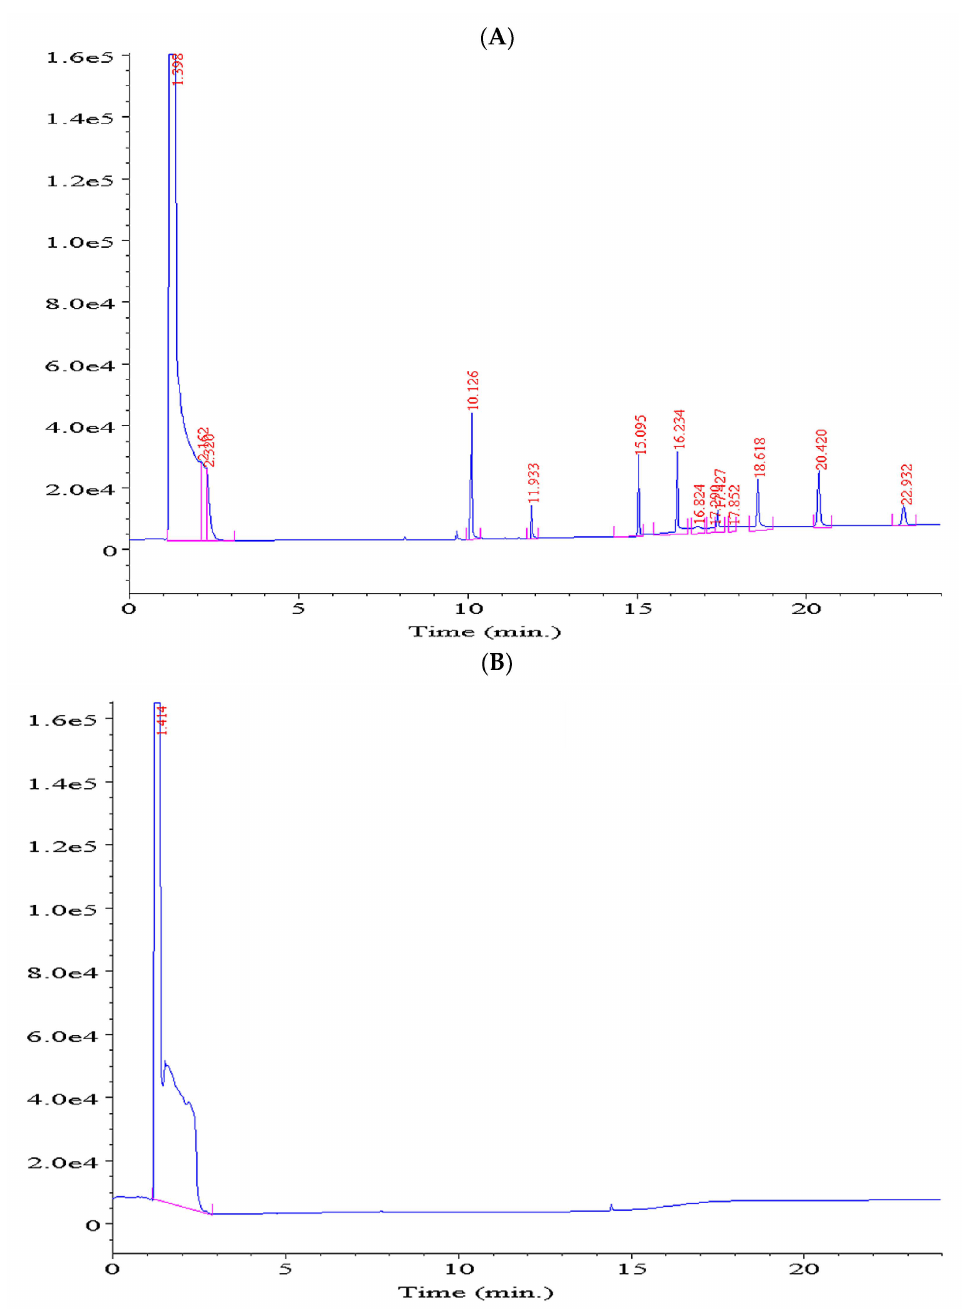
Figure 5. Chromatograms of ( A ) Aliquat 336 with a concentration of 0.1 mg · mL − 1 and ( B ) the tested soil